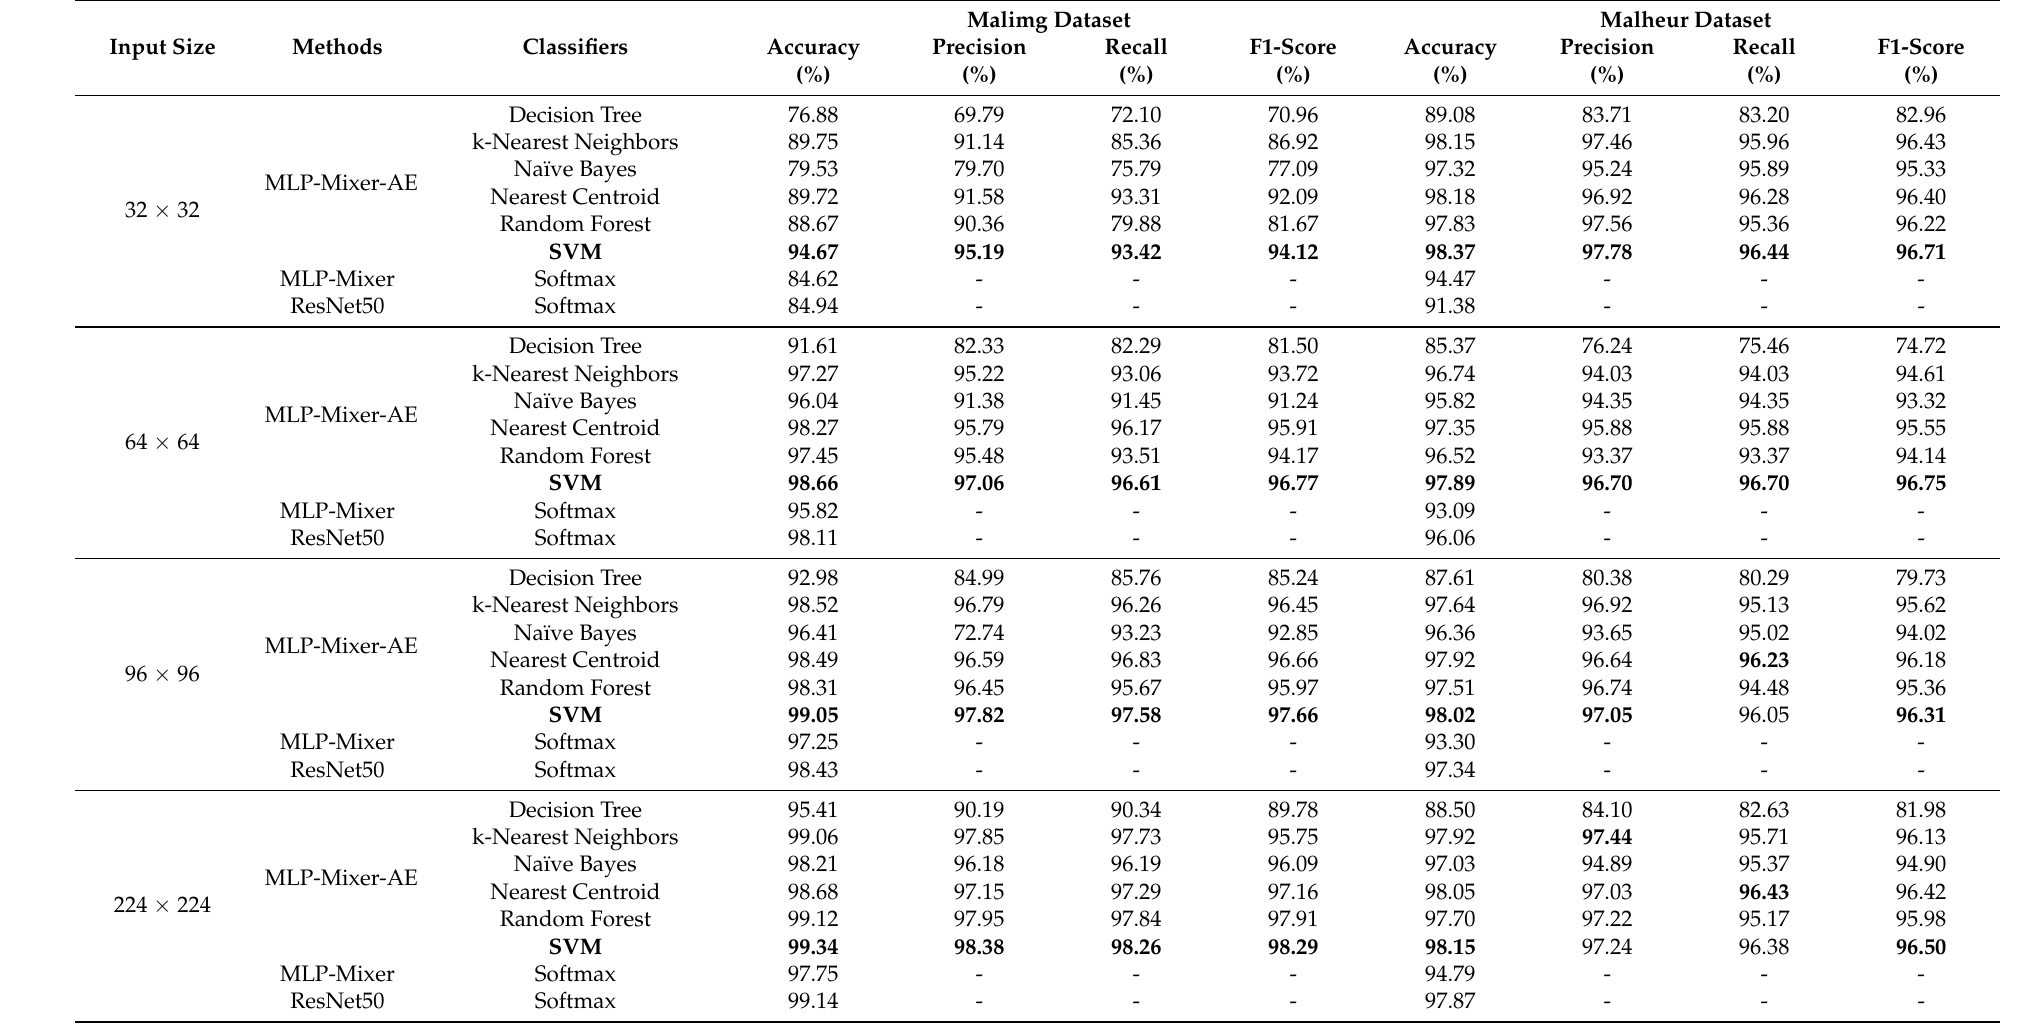
Table 5. Performance comparison according to input image